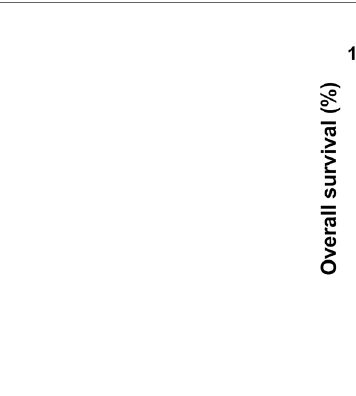
FIGURE 2 | Survival curve of patients with different stages of gallbladder cancer treated by radical